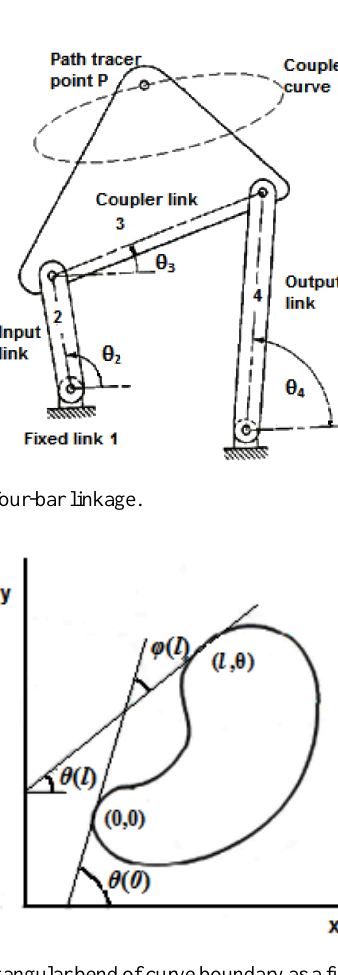
Figure 2. Net angular bend of curve boundary as a function of curve